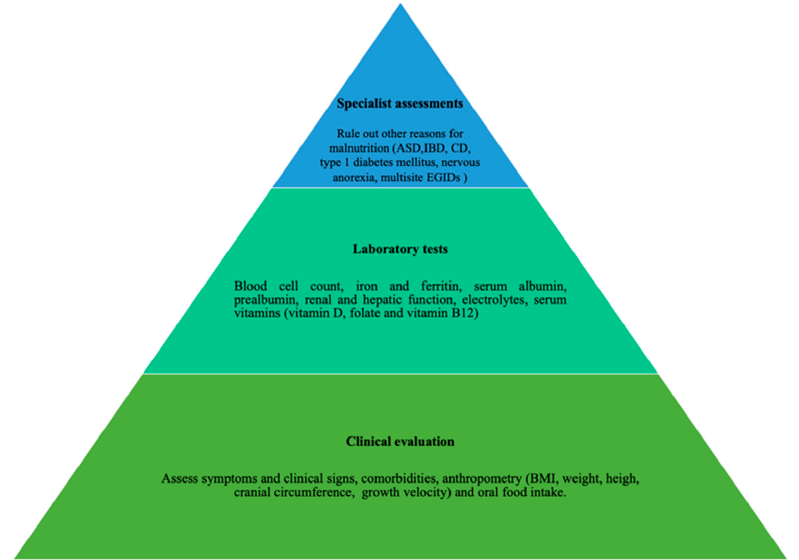
Figure 3. Nutritional status assessment of children and adolescents with eosinophilic gastrointestinal disorders.